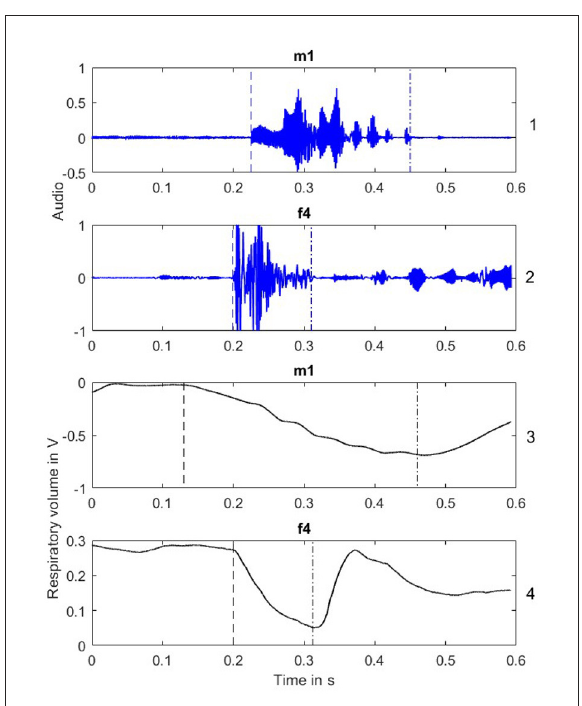
FIGURE3 Waveforms of a laugh produced by m1 (first panel, see right y-axis for panel number) and f4 (second panel). The accompanying respiratory kinematics (respiratory volume in V, arbitrary unit) are displayed in panel 3 (m1) and panel 4 (f4). Vertical dashed lines mark the onsets of laughter and dashed-dotted lines the